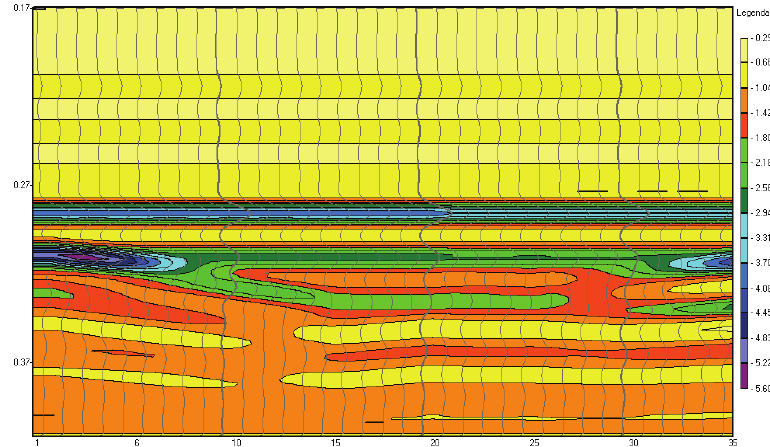
Fig. 6. Synthetic pseudoimpedance acoustic section; signal parameters: dominant frequency f 0 = 40 Hz, initial phase φ 0 = 0, the ratio of dominant frequency to dumping factor f 0 / β =2, noise 0%